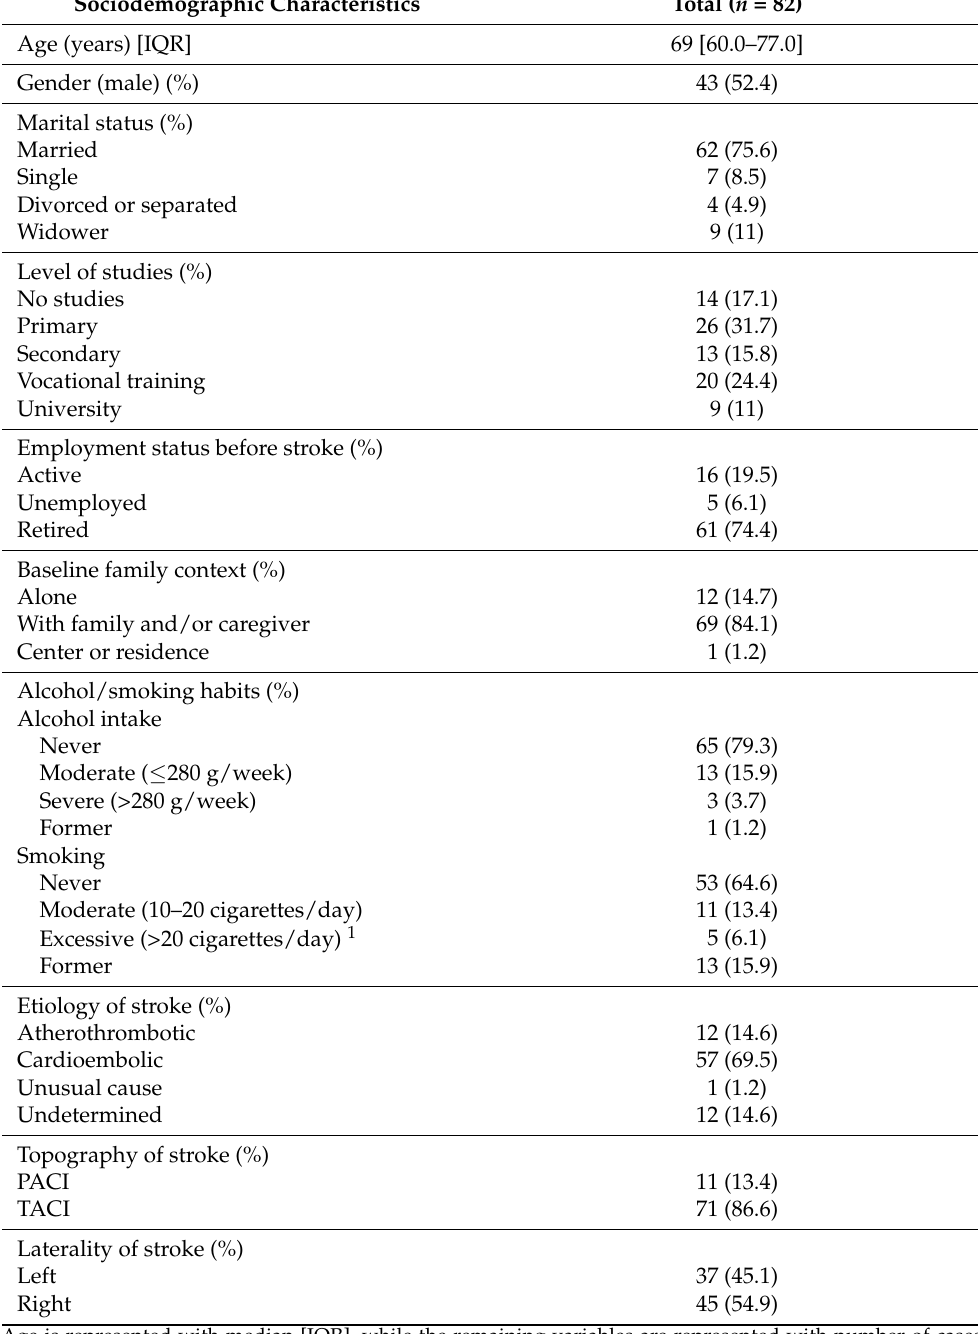
Table 1. Sociodemographic and clinicalcharacteristics of